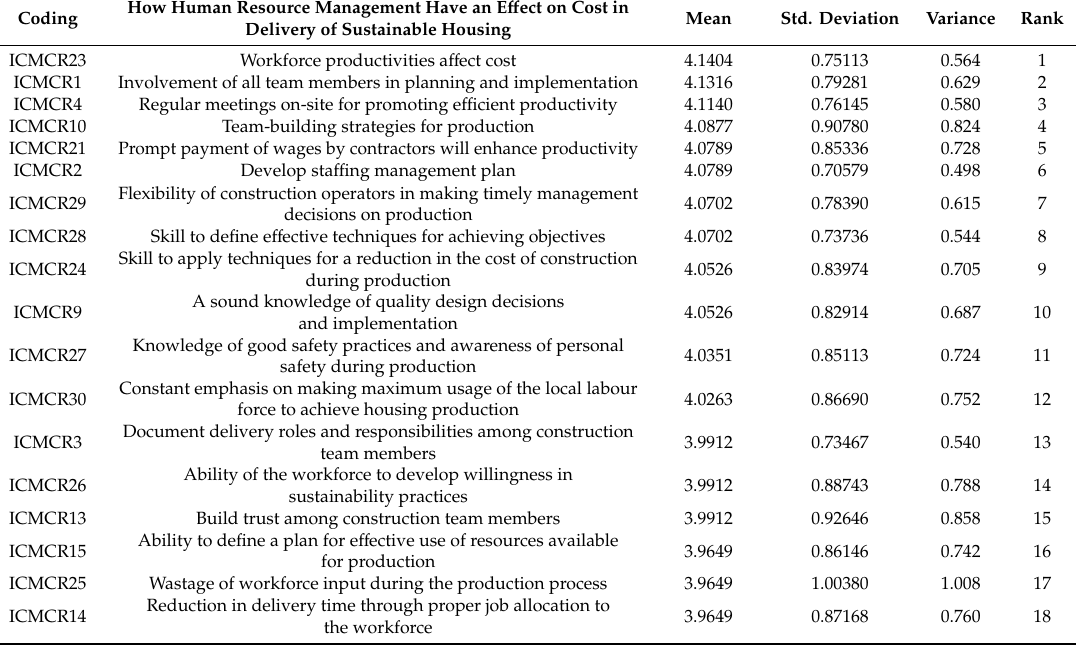
Table 2. Descriptive statistics analysis of factors that influence human